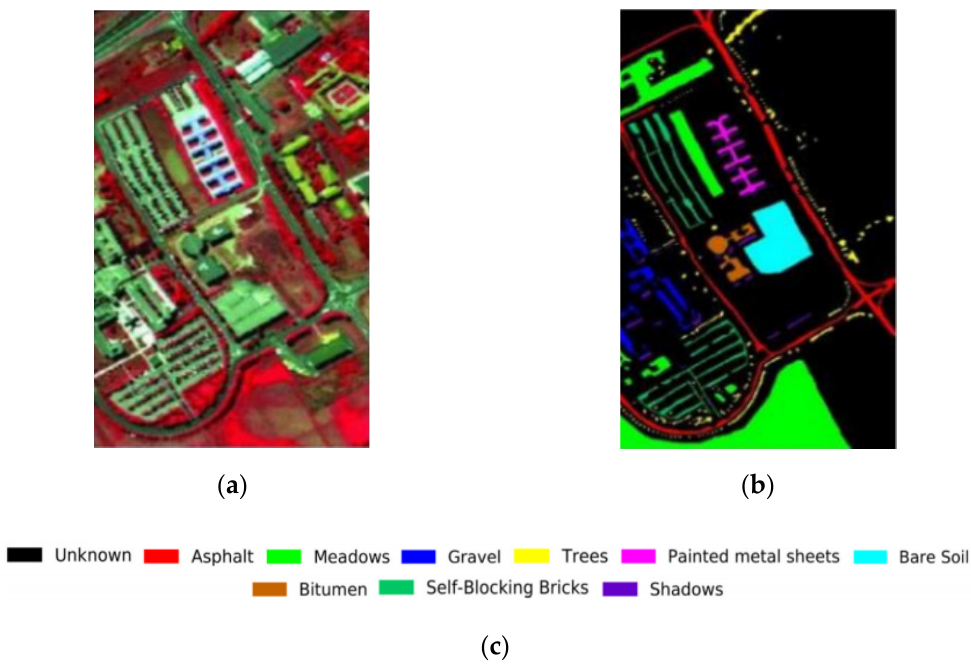
Figure 8. The University of Pavia Dataset. ( a ) The pseudo-color composite image. ( b ) The ground- truth map. ( c ) The corresponding color labels.